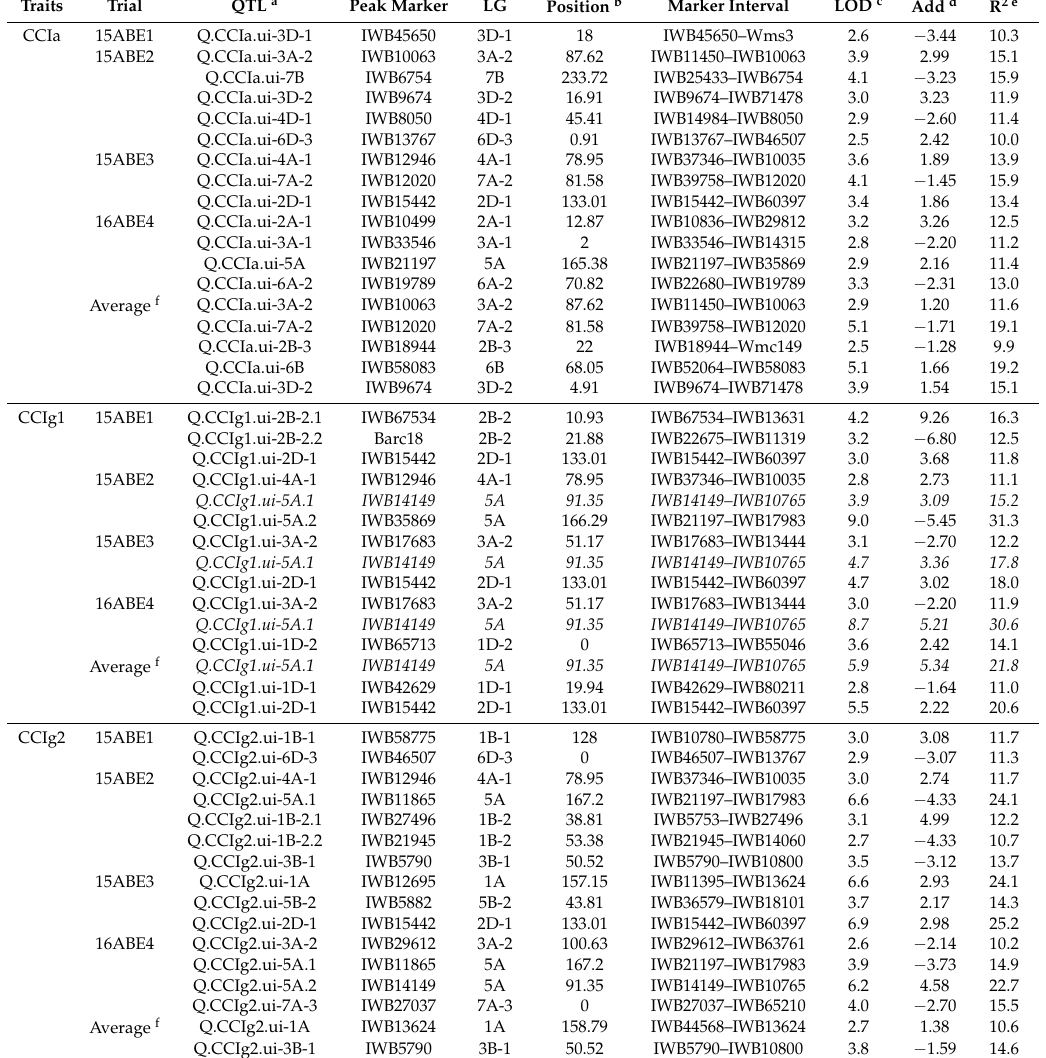
Table 5. QTL detected for chlorophyll content index in the DH population of UI Platinum/SY Capstone.